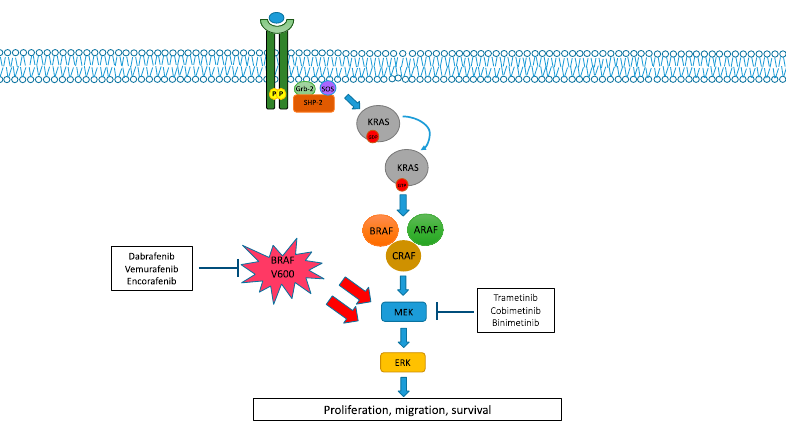
Figure 1. BRAF pathway and its inhibition. Under physiological conditions, BRAF activation strictly depends on RAS-GTP binding forms. Once activated, RAF isoforms create either homo- or hetero- dimers, eventually leading to the phosphorylation of MEK 1/2 and their downstream pathway. Con- versely, BRAF class I mutations can directly activate downstream MEK 1/2 in an RAS-independent manner, resulting in deregulated proliferation and survival. BRAF inhibitors (dabrafenib, trametinib and encorafenib) combined with MEK inhibitors (trametinib, cobimetinib and binimetinib) eventually hinder downstream signalling.